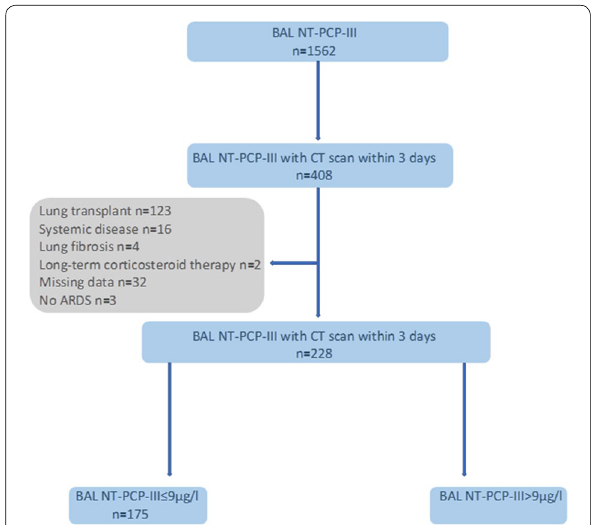
Fig. 1 Flow chart. NT‑PCP‑III: N‑terminal peptide for type